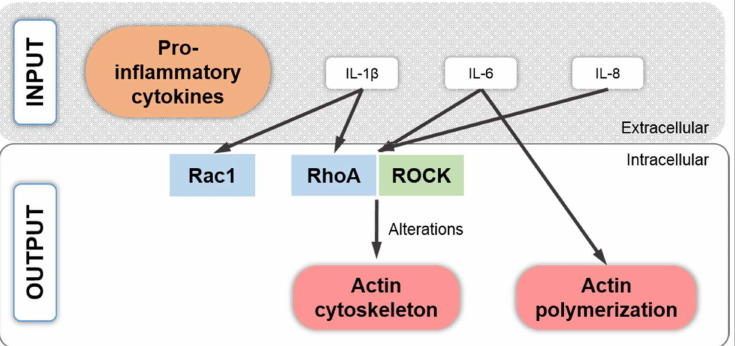
Figure 6. Signaling of pro-inflammatory cytokines IL-1 β , IL-6, and IL-8, causing alterations in the actin cytoskeleton by signaling through the RhoA/ROCK or Rac1 pathway. Abbreviations: IL-1 β : interleukin-1 β , IL-6: interleukin-6, IL-8, interleukin-8, ROCK: